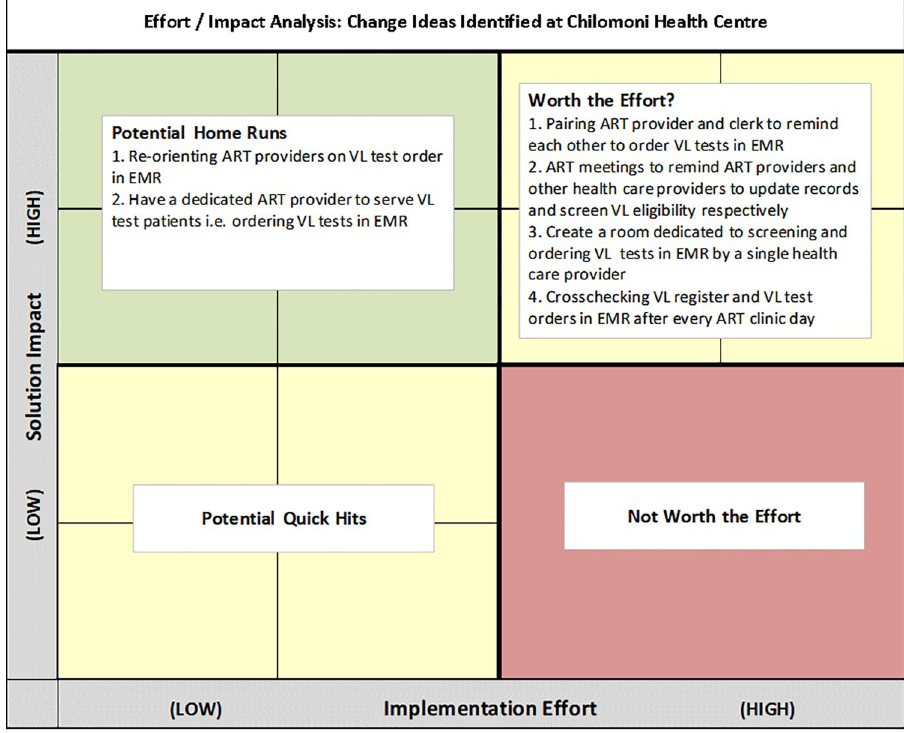
Fig 3. Effort-Impact Matrix of change ideas identified at Chilomoni health centre in